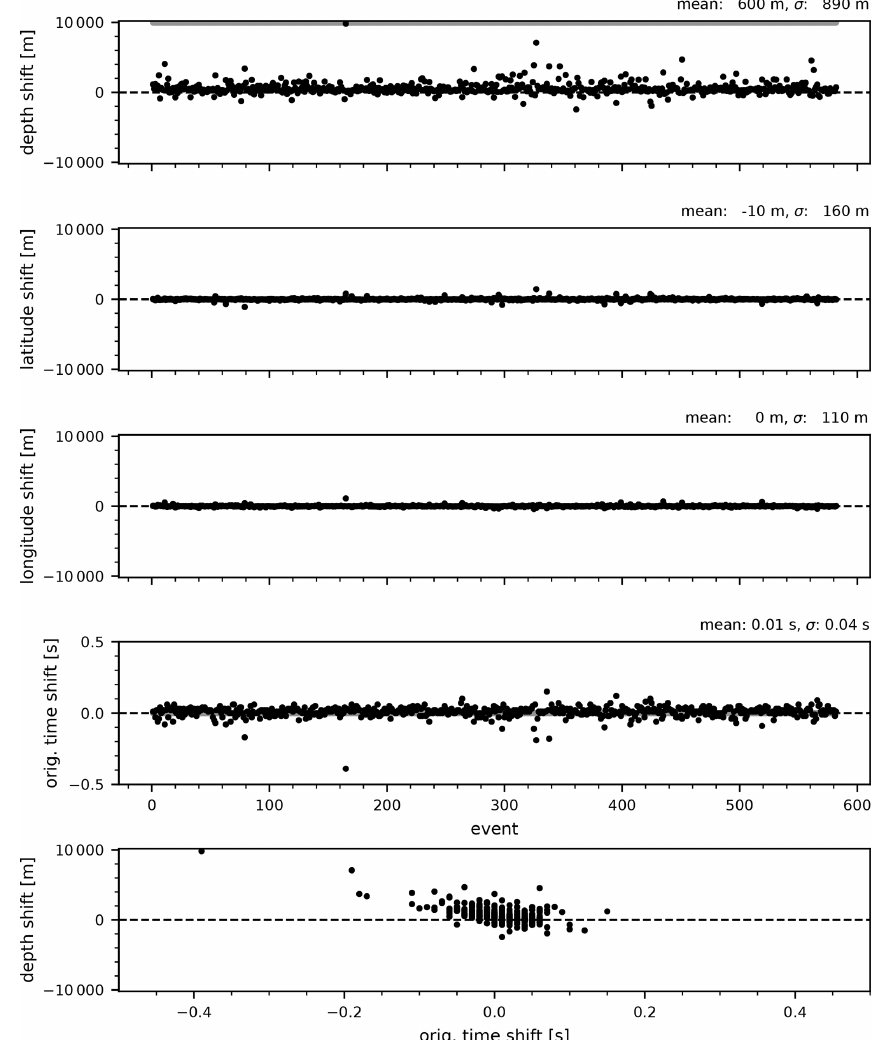
Figure 9. Systematic hypocenter shift test. Hypocenters obtained with the MPS velocity model were shifted systematically in depth by 10km (grey dots at the top of the first plot) and used as an input in another inversion run with nine iterations. Black dots show the resulting shifts in the hypocenter parameters remaining after this test. All shifts are referenced to hypocenter parameters obtained with the MPS velocity model.